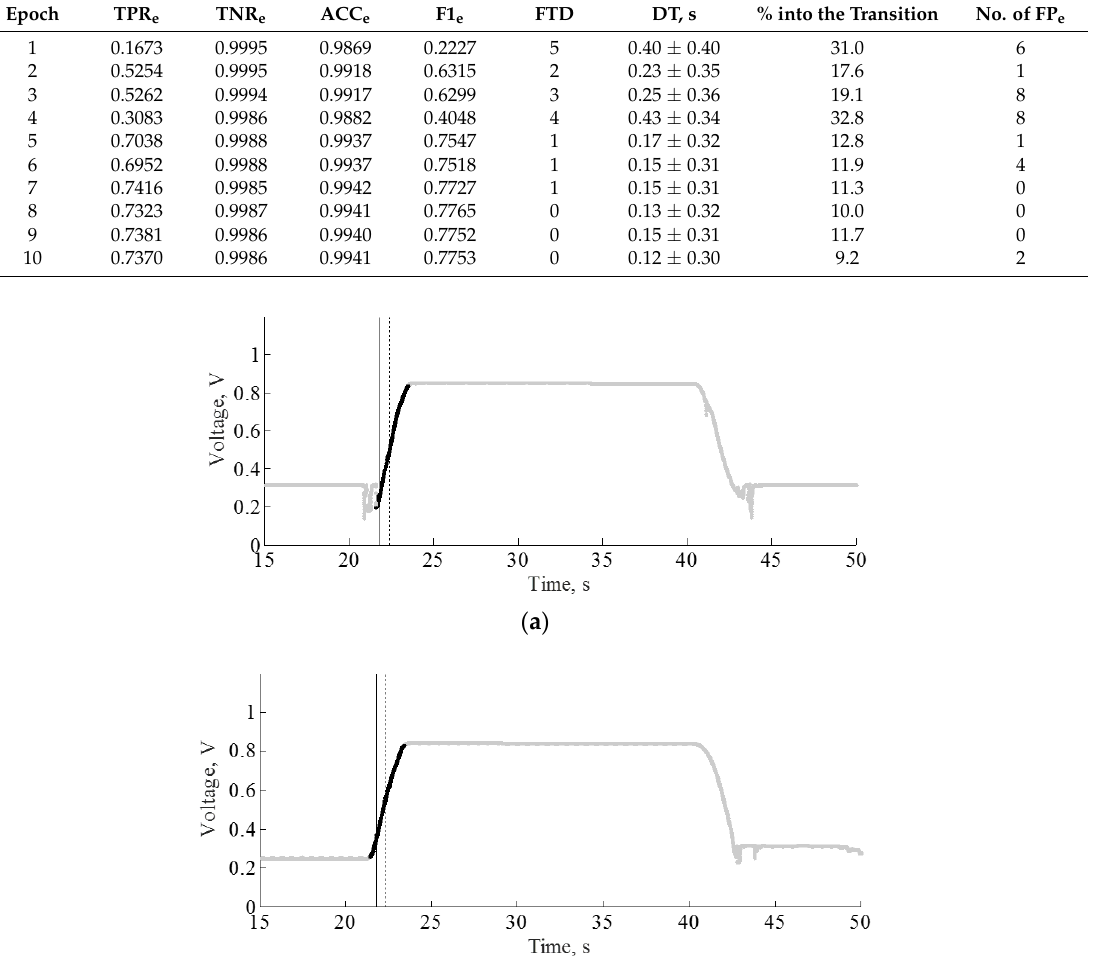
Figure 5. Activity mode of knee potentiometer of two different activities with different trials. Black solid lines represent detected transitions ( a ) activity-2 trial-6; ( b ) activity-6